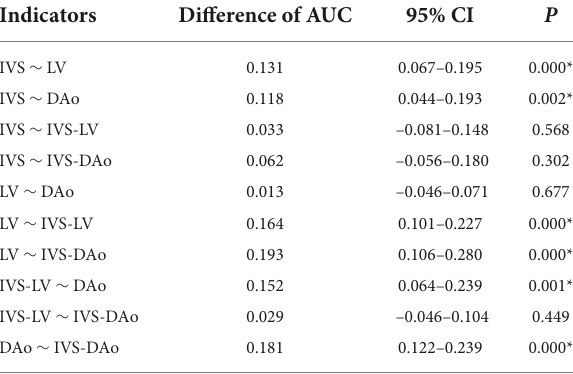
TABLE 7 DeLong test between AUC values of each index in LDCT group.